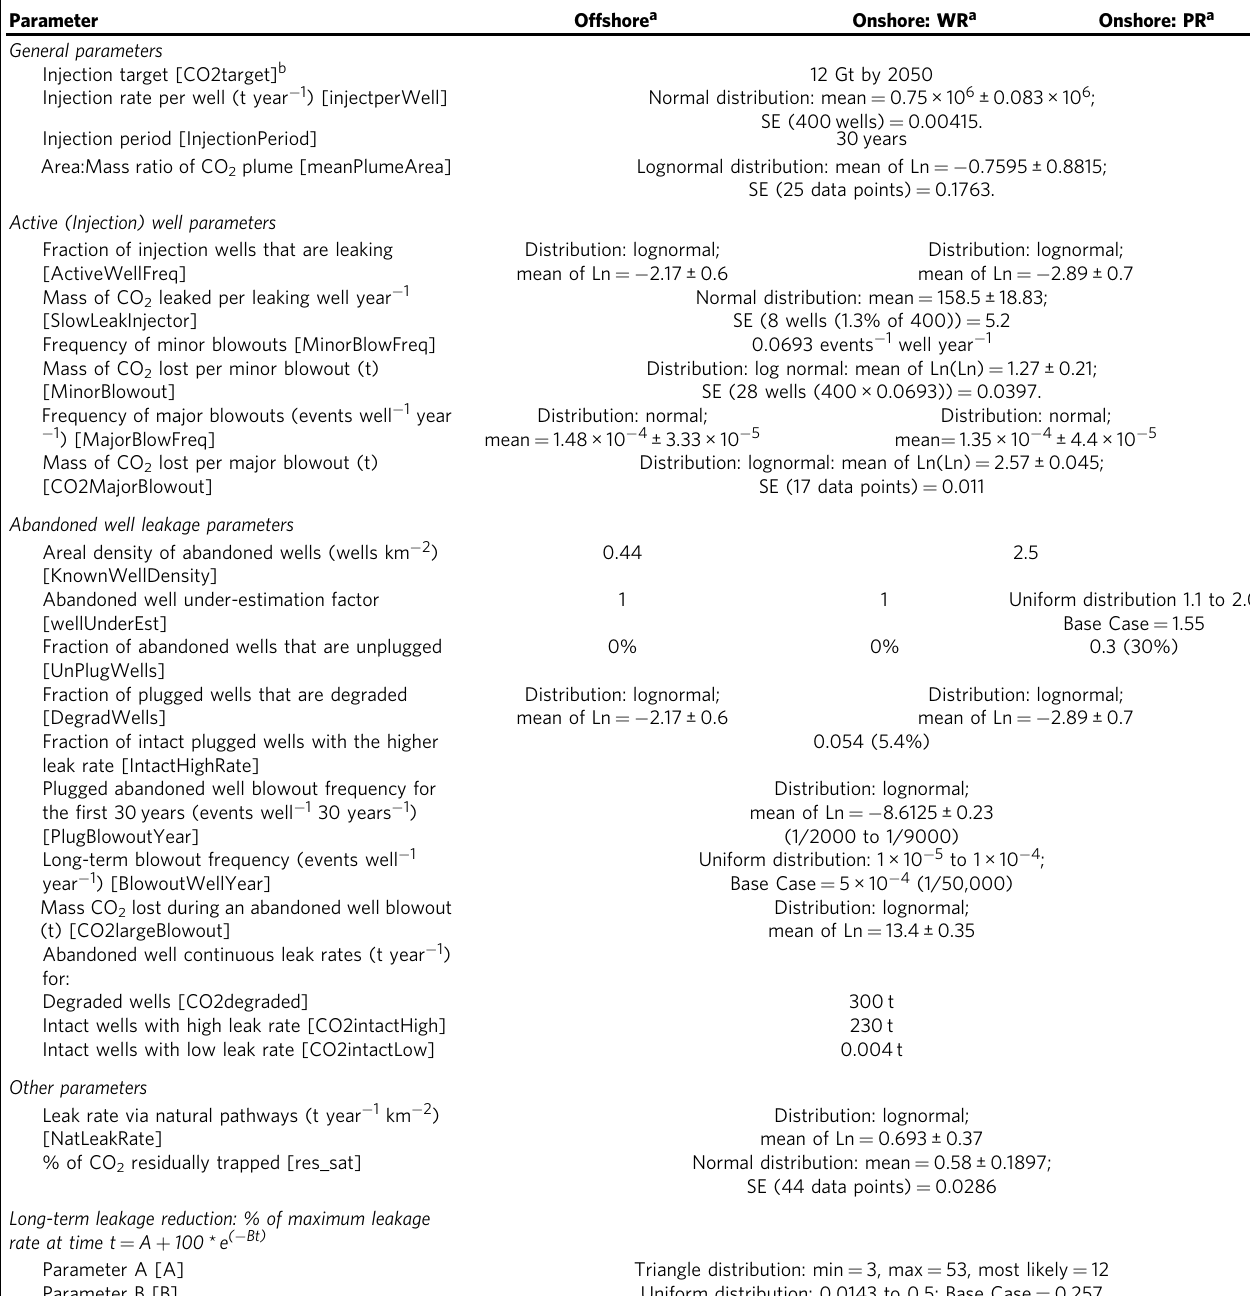
Table 3 Input parameters for the model